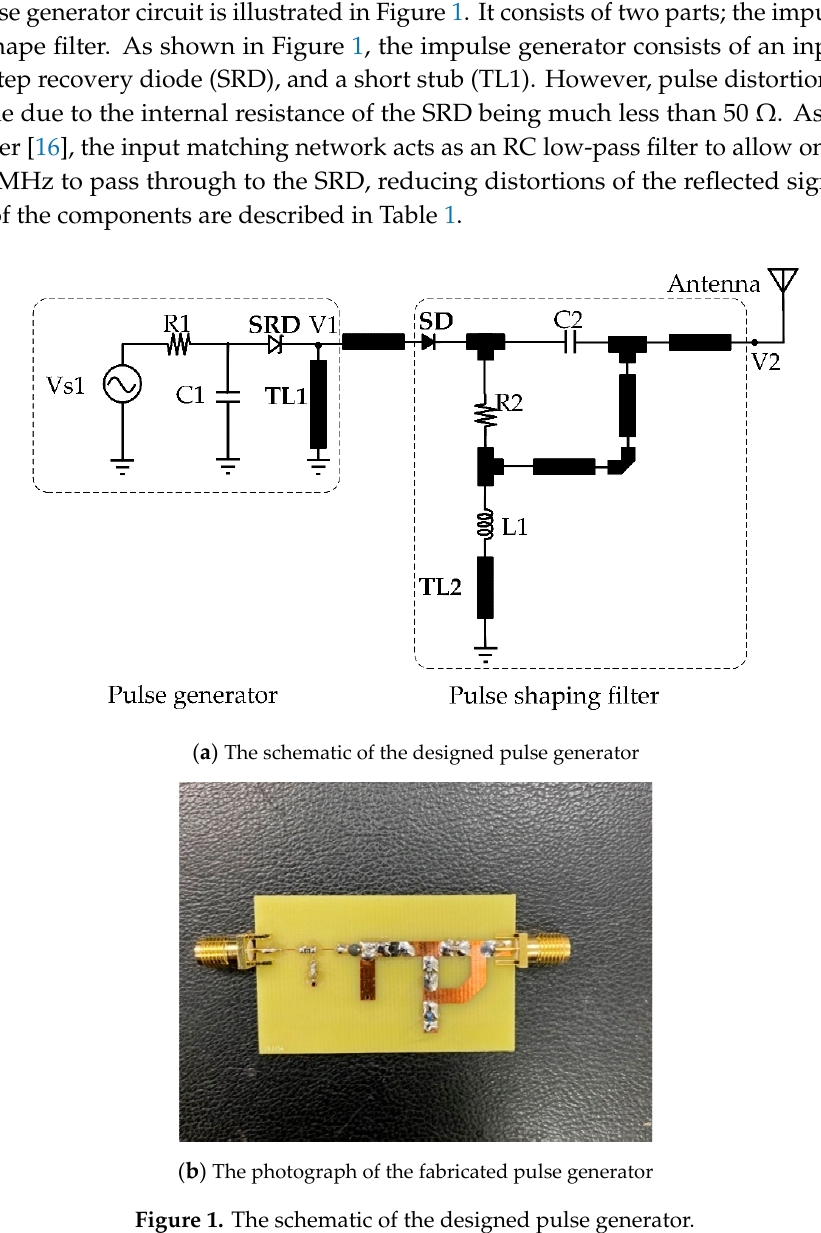
Figure 1. The schematic of the designed pulse generator . Table 1. Circuit implementation information.